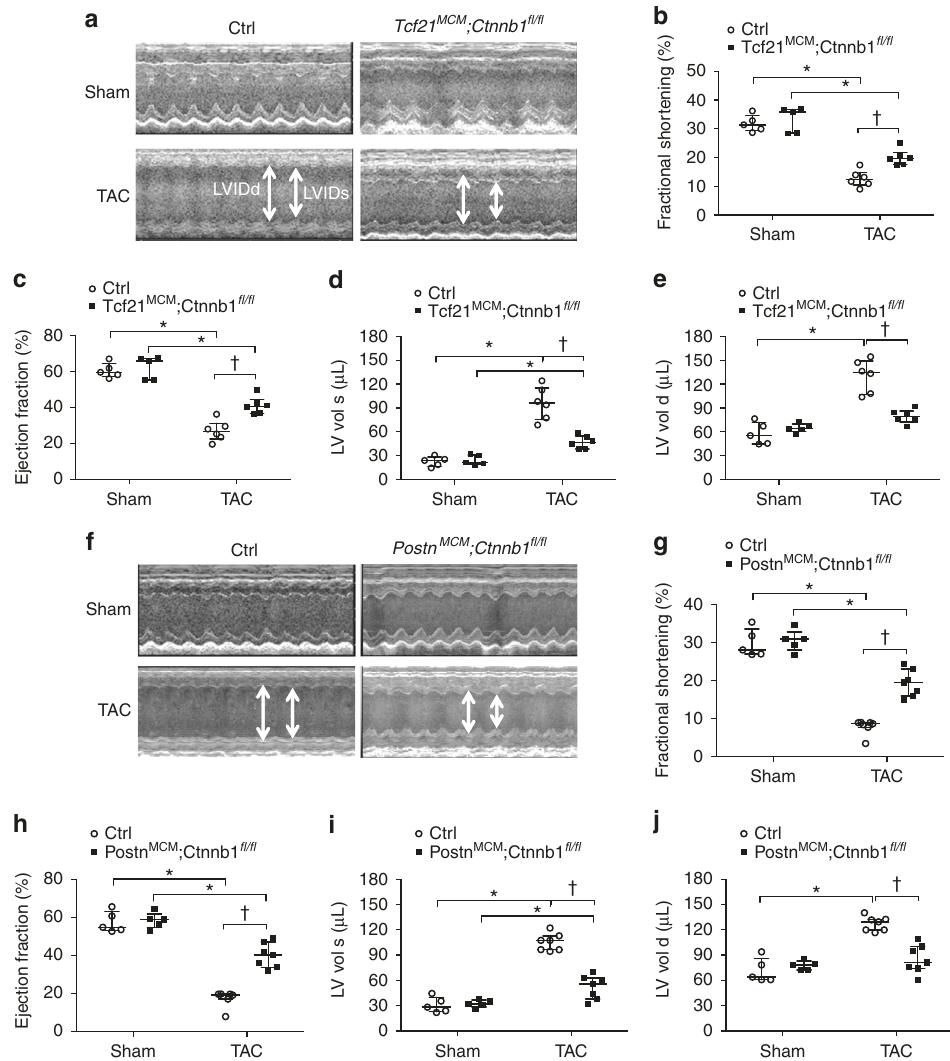
Fig. 2 Loss of β -catenin in Tcf21 or Postn CF lineages leads to improved cardiac function 8 weeks post TAC. Tcf21 MCM ;Ctnnb1 fl / fl and Postn MCM ;Ctnnb1 fl / fl mice with corresponding Cre-negative controls were subjected to sham or TAC operations. Cre-activity was induced by TAM food for 8 weeks from day 0 after operation, and cardiac function was measured by echocardiography. Representative M-mode tracing for Tcf21 MCM ;Ctnnb1 fl / fl ( a ) and Postn MCM ; Ctnnb1 fl / fl ( f ) with corresponding Cre-negative controls at 8 weeks post sham or TAC operations are shown. Arrows indicate left ventricular internal diameter end diastole (LVIDd, left ) and end systole (LVIDs, right ). b , g Fractional shortening (FS), ( c , h ) ejection fraction (EF), ( d , i ) LV systolic (LV Vol s), and ( e , j ) LV diastolic volume (LV Vol d) were quanti fi ed. No differences were observed between sham groups. TAC signi fi cantly impaired cardiac function compared to sham control after 8 weeks. Compared to Cre-negative littermate controls, FS, EF, and LV Vol were signi fi cantly improved in both Tcf21 MCM ; Ctnnb1 fl / fl ( b – e ) and Postn MCM ;Ctnnb1 fl / fl ( g – j ) mice at 8 weeks post TAC. Data points are shown with median and interquartile ranges indicated. Statistical signi fi cance was determined by Kruskal – Wallis tests followed Mann – Whitney U tests for pairwise comparisons using Bonferonni adjustments to control